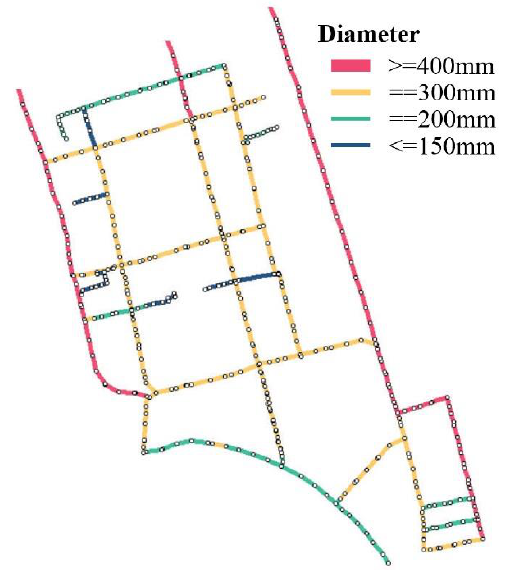
Figure 6. The study water supply